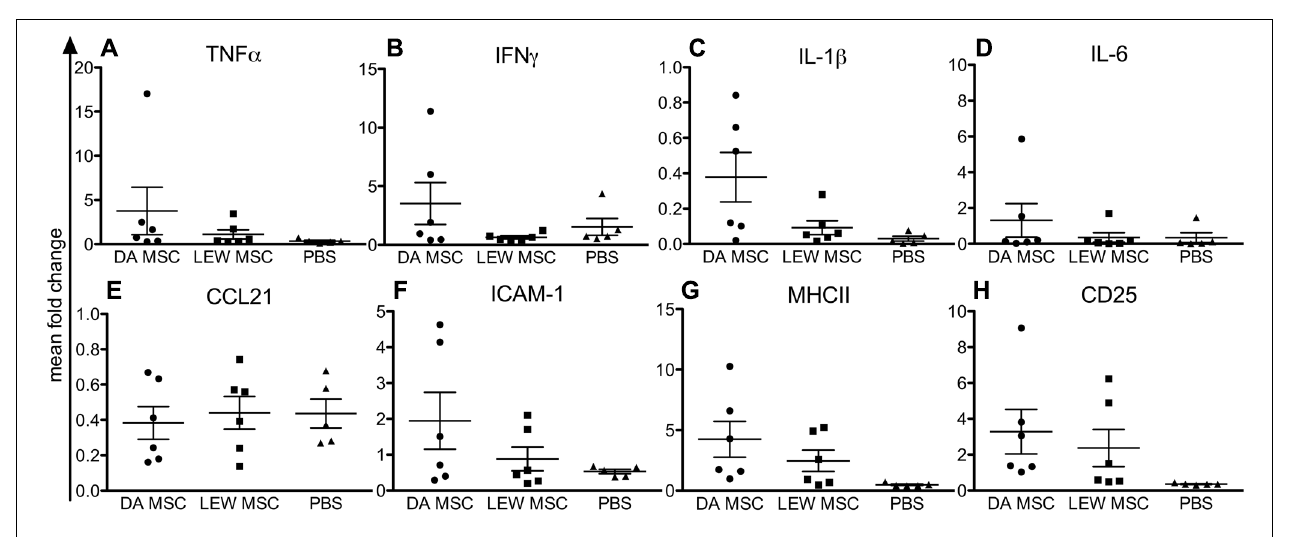
FIGURE 4 | Elevated immune cell activation in rat spleens following MSC pre-treatment measured by gene expression analysis. Quantitative real-time PCR was performed on spleens harvested 8–10 days after kidney transplantation. After expression of the target gene was normalized to the housekeeping gene β -actin, the mean fold increase of the target gene in the